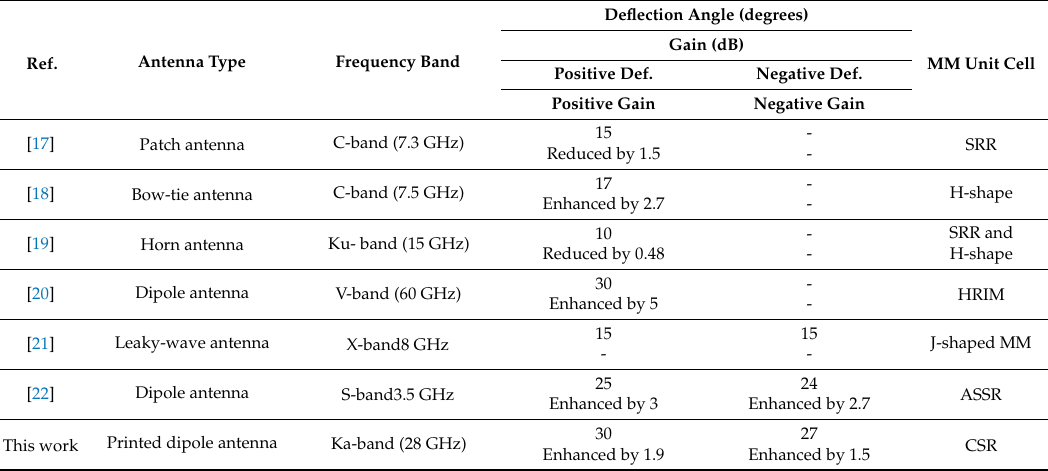
Table 2. Comparison of the present work with that reported literature for beam deflection using MM structures. SSR = split-ring